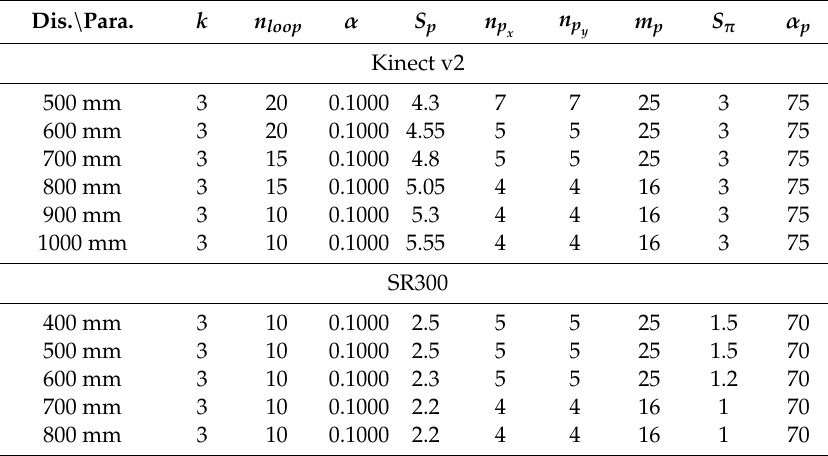
Table 1. Experimental